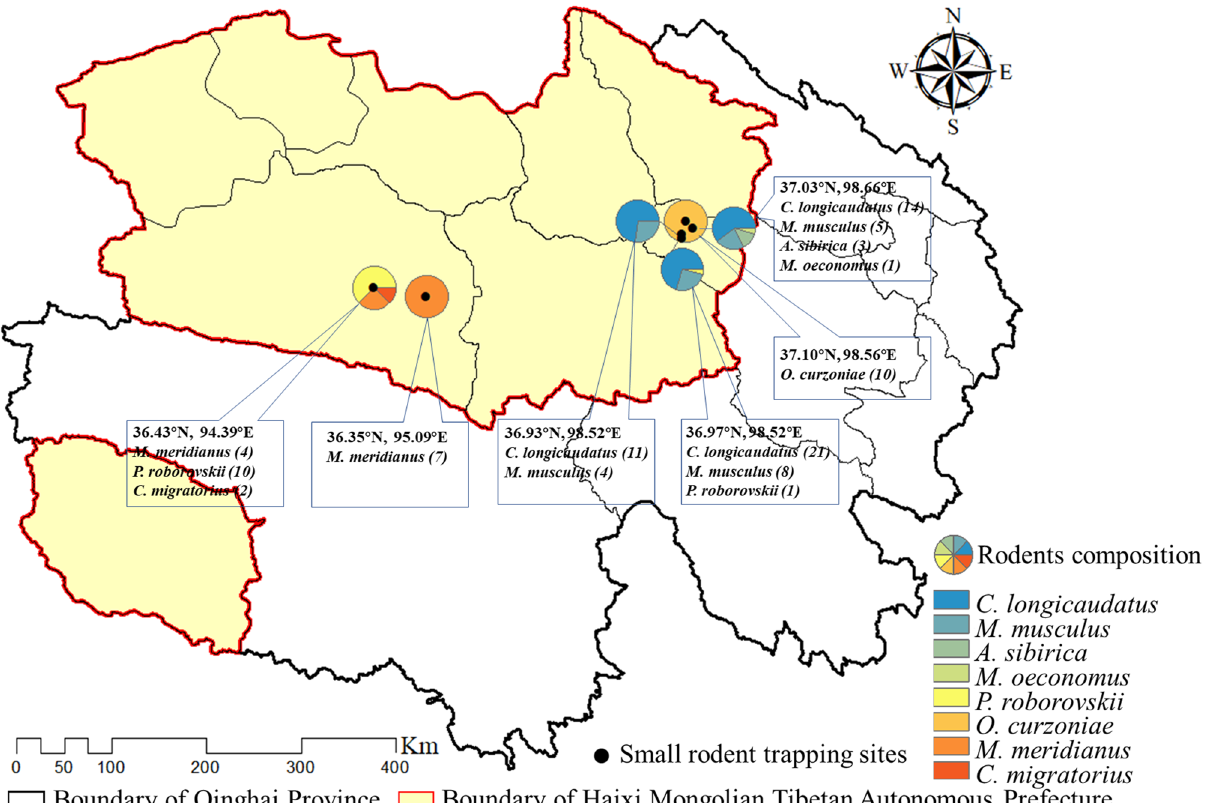
Figure 1. Geographical distribution of the trapped small mammals and the study areas consist of the sampling sites in two counties of Haixi Prefecture,